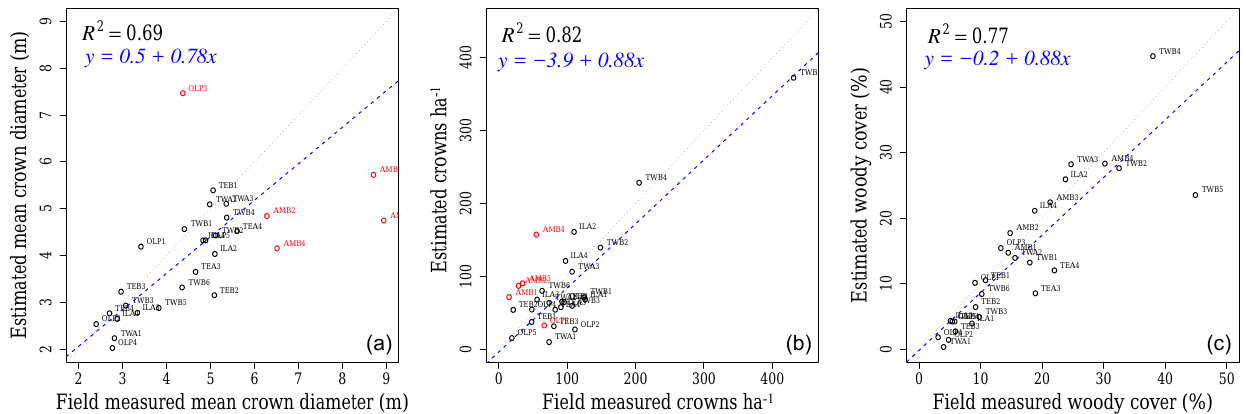
Figure A3. Validation of estimated mean crown size, crown density, and woody cover. The Amboseli sites and one site in Ol Pejeta were excluded when calculating R 2 for mean crown size and crown density. These sites are shown in red.